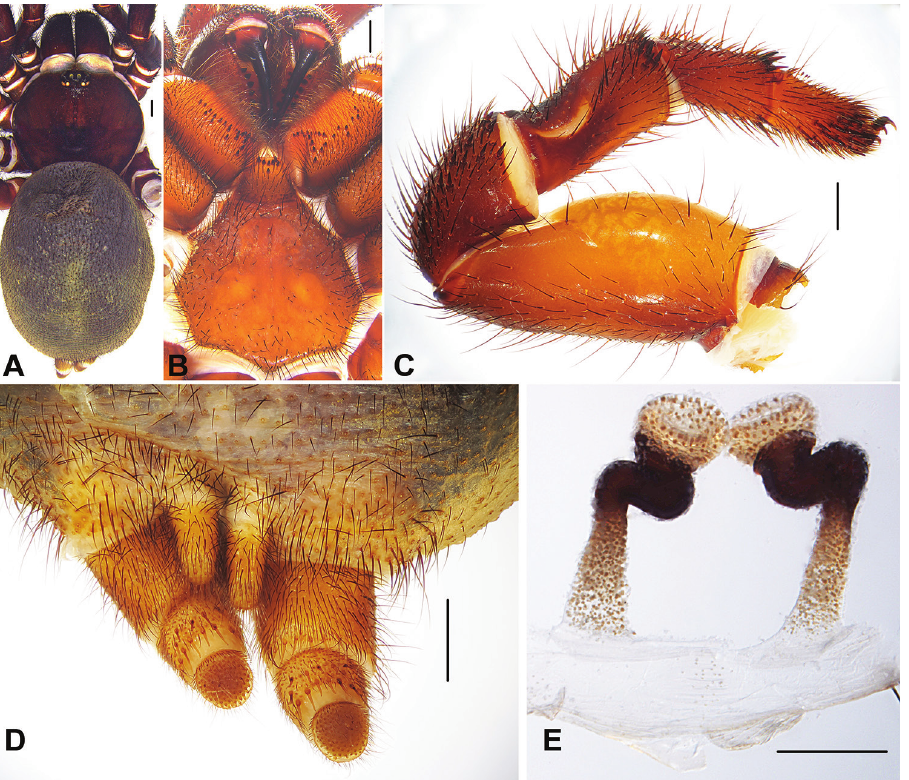
Figure 3. A General somatic morphology of Conothele sidiechongensis Xu, Xu & Liu, sp. n. (female, C-YN-005) B chelicerae, labium, coxae of palp and sternum, ventral view C left leg III, prolateral view D spinnerets, ventral view E female genitalia, dorsal view. Scale bars: A–D 1 mm, E 0.5 mm. 4 slender setae on eye tubercle and 5 on its back. Caput arched. Fovea deep, strongly procurved and U-shaped (Fig. 3A). Eye tubercle black and low. Eight eyes in two rows, with the anterior eye row slightly procurved and posterior row straight from above